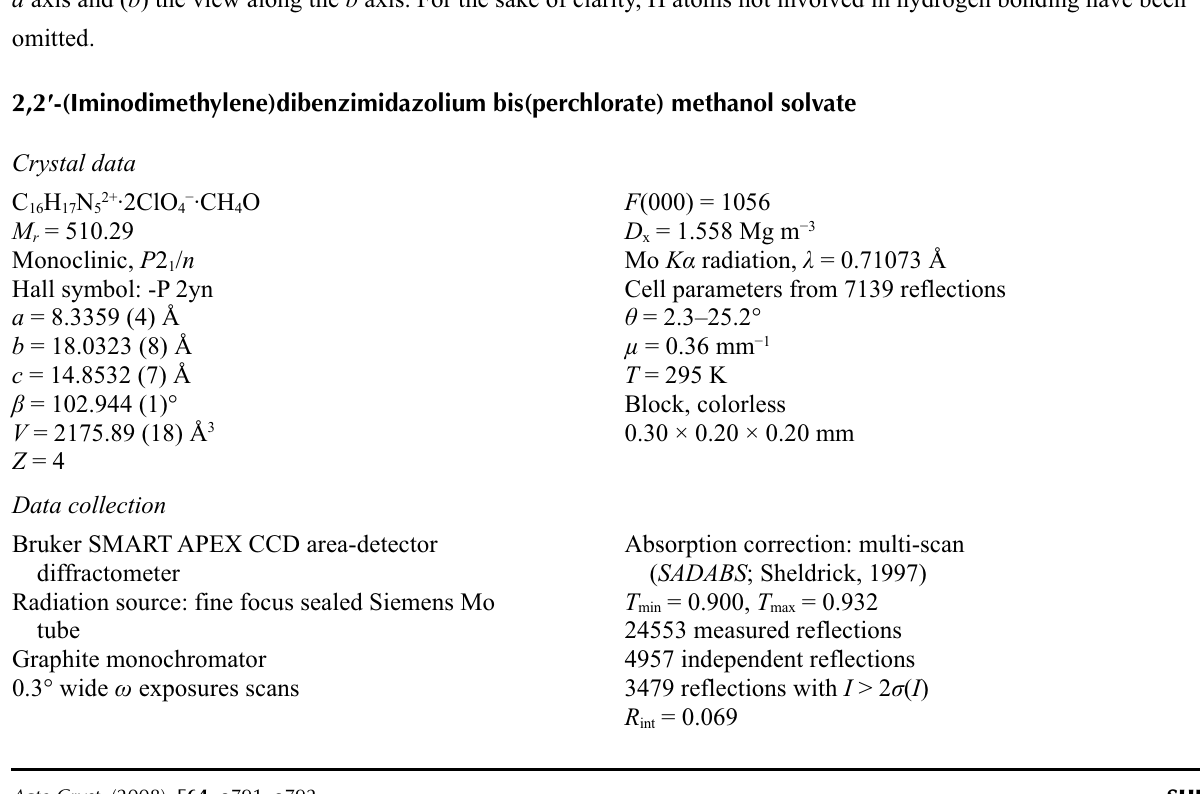
Part of the crystal structure of the title compound, showing the formation of the two-dimensional network parallel to the (010) plane, built from N—H···O and O—H···O hydrogen bonds which are shown as dashed lines. ( a ) the view along the a axis and ( b ) the view along the b axis. For the sake of clarity, H atoms not involved in hydrogen bonding have been